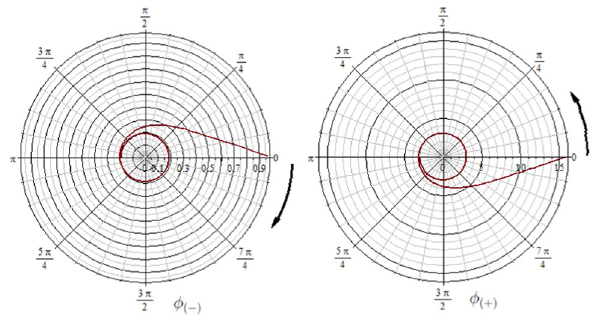
( ± ) (φ) of the spiral photon geodesics rolling out and escaping from the photon sphere of radius 3 M